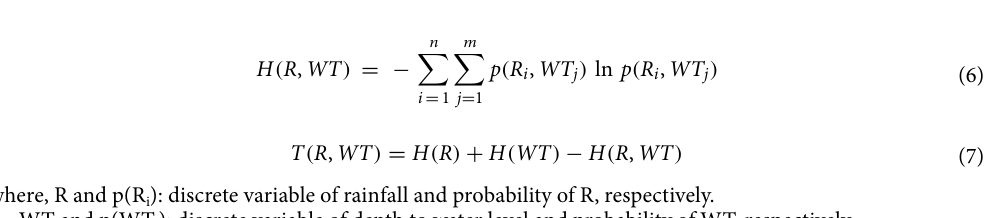
Figure 2. Flowchart for estimating groundwater reserve using an information-based model at the proximity of a morphodynamic system in a part of the Ganga basin, Northern